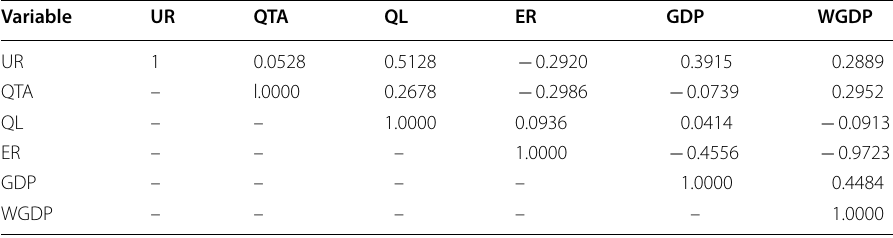
Table 4 Pearson correlation coefficient test for each independent variable